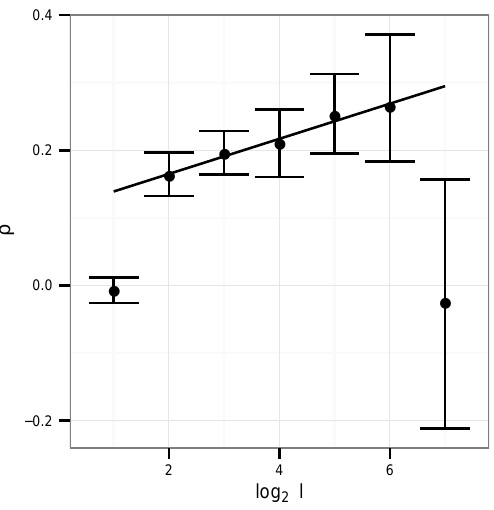
Figure 8. The empirical means of the increments, averaged over Figure 10. The empirical ρ of the increments, averaged over all im- all images, and its fit. The error bars denote the 25th and 75th per- ages, and its fit.The error bars denote the 25th and 75th percentiles. Fig. 8. The empirical means of the increments, averaged over all images, and its fit. The errorbars denote Fig. 10. The empirical ρ of the increments, averaged over all images, and its fit.The errorbars denote the centiles. There does appear to be some steady behaviour, but it ap- Almost the exact same pattern is observed as for γ . th and 75 th percentiles. There does appear to be some steady behavior, but it appears highly com- the 25 pears highly complex, with relatively small values suggesting that 25 th and 75 th percentiles. Almost the exact same pattern is observed as for γ . plex, but with relatively small values suggesting that the mean might be sufficient to model its behavior. the mean might be sufficient to model its behaviour.